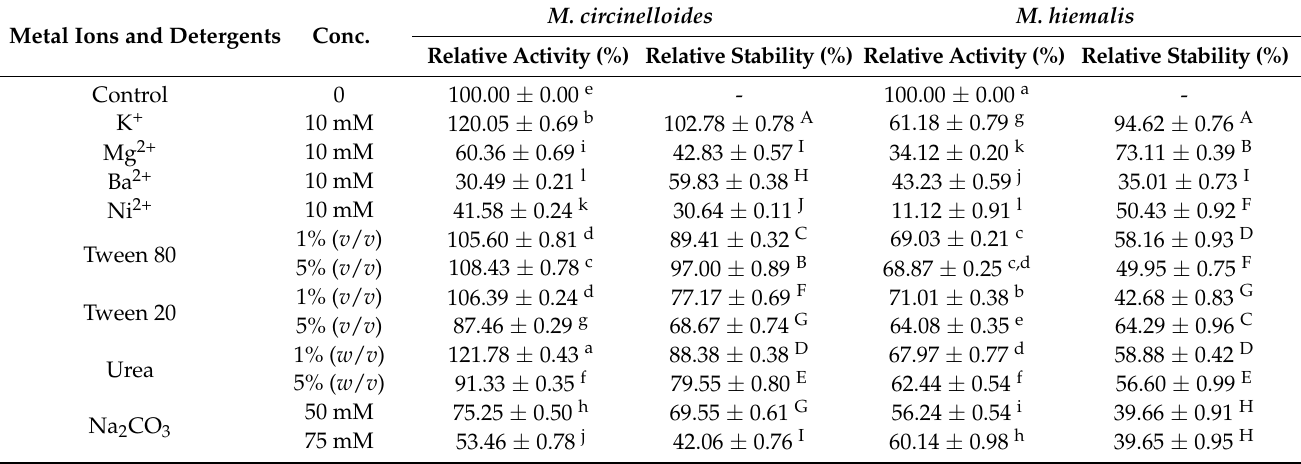
Table 11. Effects of metal ions and detergents on activity and stability of partially purified pecti- nase from M. circinelloides and M. hiemalis .